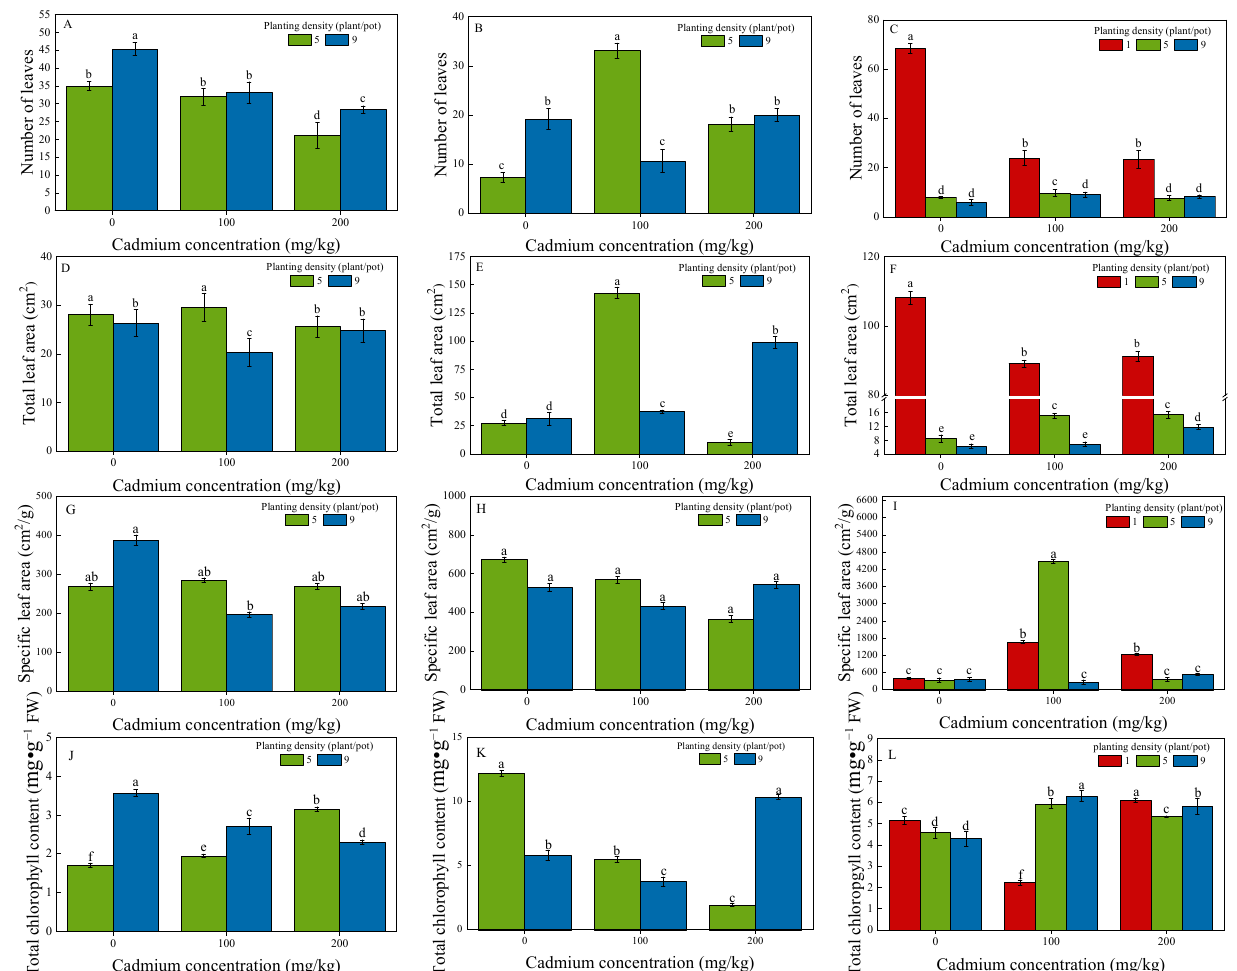
Figure 3. Traits related to photosynthesis of A. philoxeroides and T. regens subjected to cadmium concentration and planting density. ( A , D , G , J ), ( B , E , H , K ), and ( C , F , I , L ) were the traits related to photosynthesis of A. philoxeroides in mixed culture, the traits related to photosynthesis of T. regens in mixed culture, and the traits related to photosynthesis of A. philoxeroides in monoculture, respectively. Lowercase letters indicate a significant difference ( p < 0.05) in A. philoxeroides or T. regens present on each treatment based on post hoc multiple comparisons in Duncan with cadmium concentration and planting density as fixed factors.